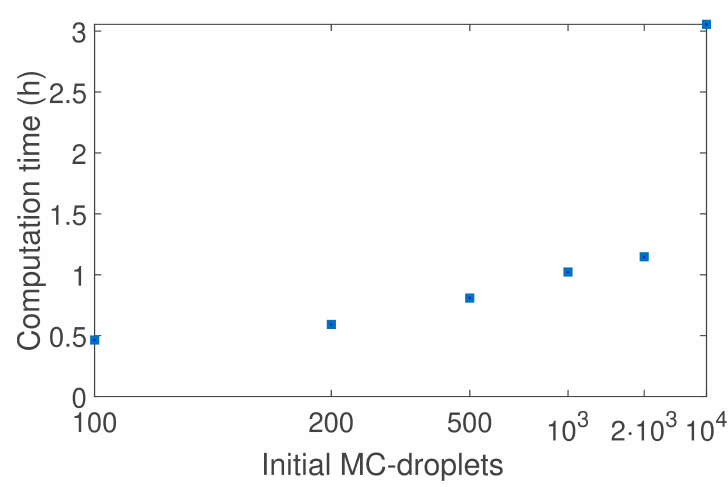
Figure 4. Influence of the number of initial MC-droplets per single Monte Carlo simulation on = 1.1 and 100 computation time for σ g,D 0